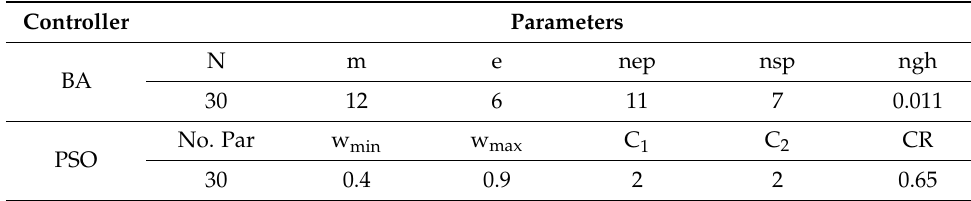
Table 3. The BA and PSO parameters.